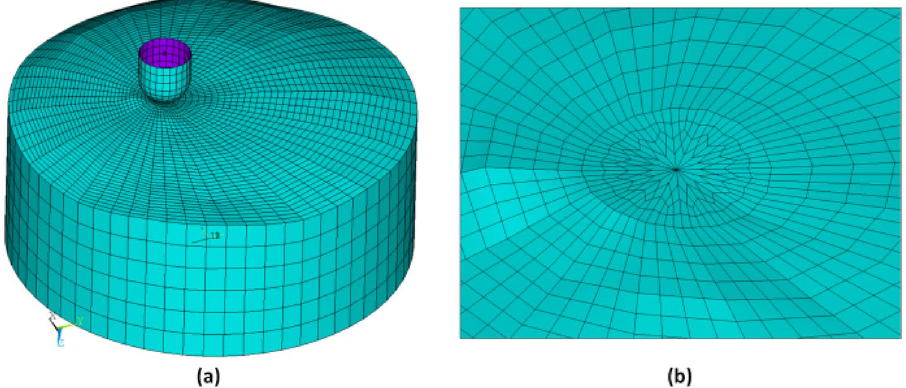
Fig. 5. 3D model using mapped mesh of a the entire specimen b close-up view of the indented